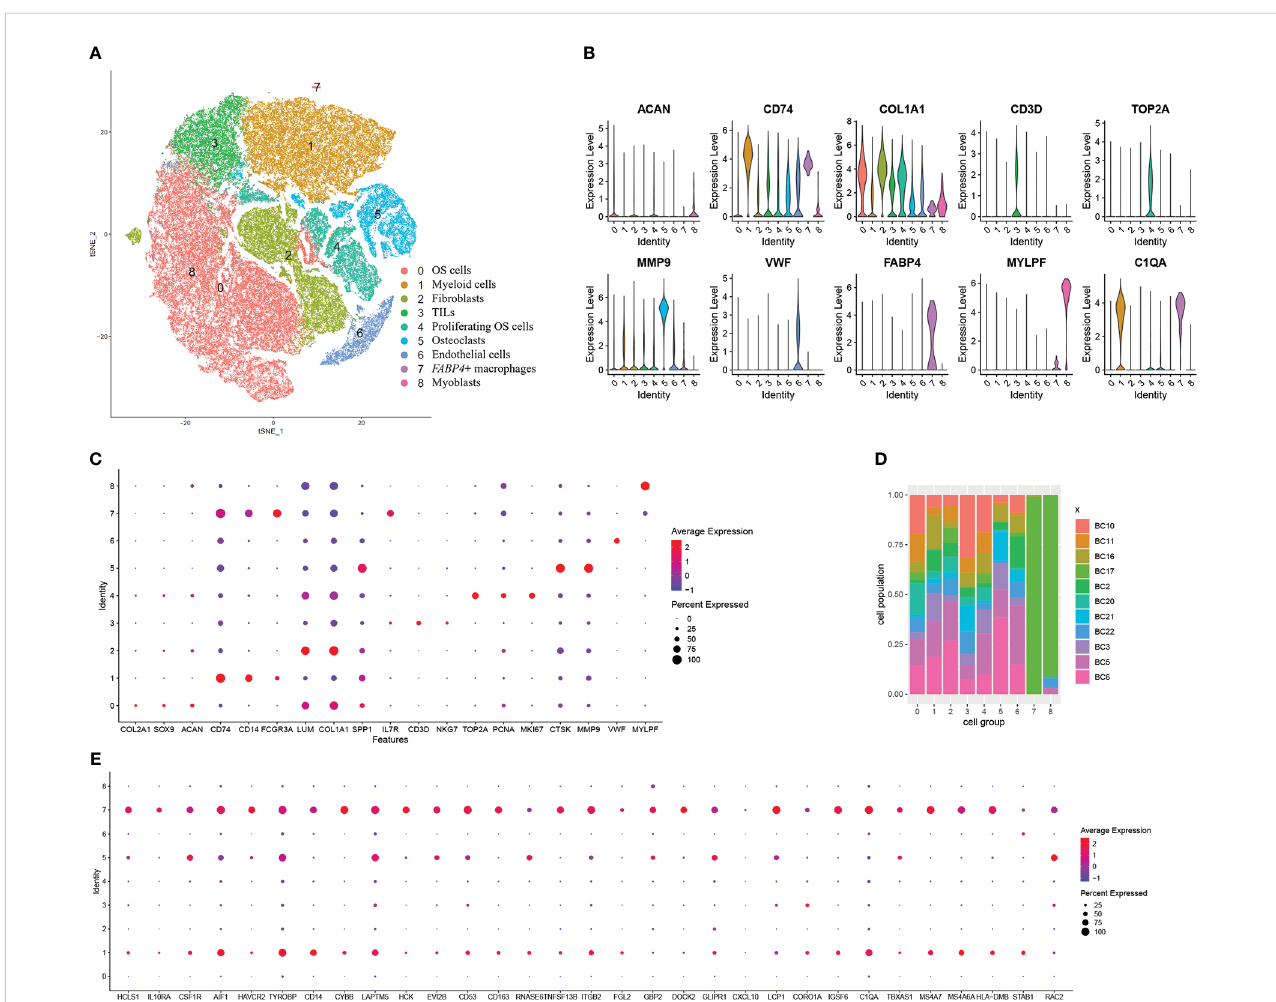
FIGURE 3 Single-cell transcriptomic analysis reveals the transcriptome of cells in the microenvironment of OS. (A) The t-distributed stochastic neighbor embedding (t-SNE) plot of the nine identi fi ed main cell types in OS lesions. (B) Violin plots showed the normalized expression levels of eight representative canonical markers across the nine clusters. (C) Representative marker expression in nine clusters of cells. Dot size indicates the proportion of cells expressing markers. Dot color shows the average expression level of the markers. (D) Distribution of the nine clusters among 11 patients with OS. (E) Dot plot of the 34 overlapped DEGs showing their expressing proportion and level among nine